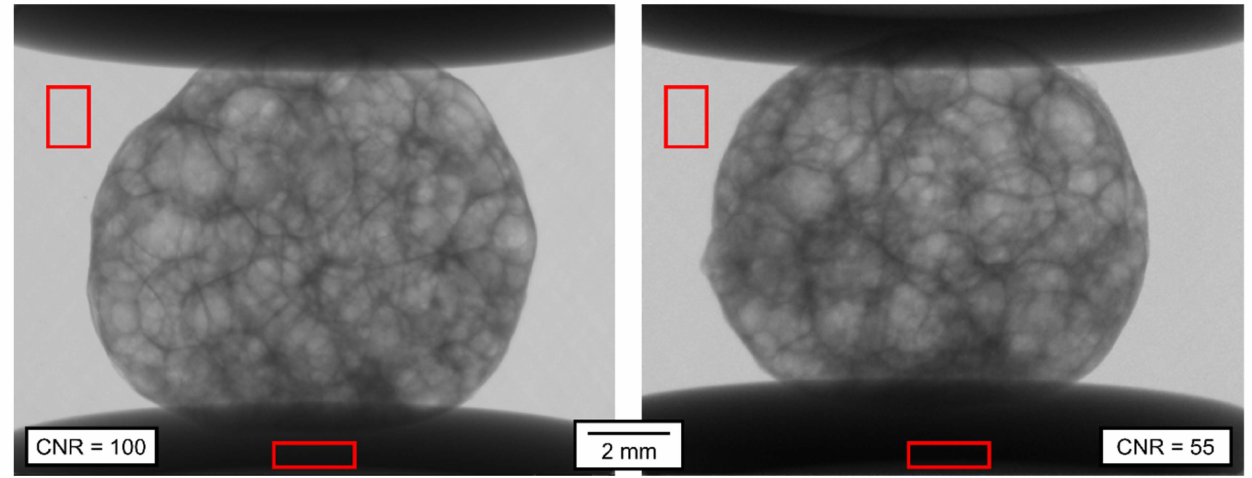
Figure 6. Comparison of the radiographic projections of the APM foam elements. Left : Mode B; Right : Mode D. ROIs for CNR evaluation indicated in